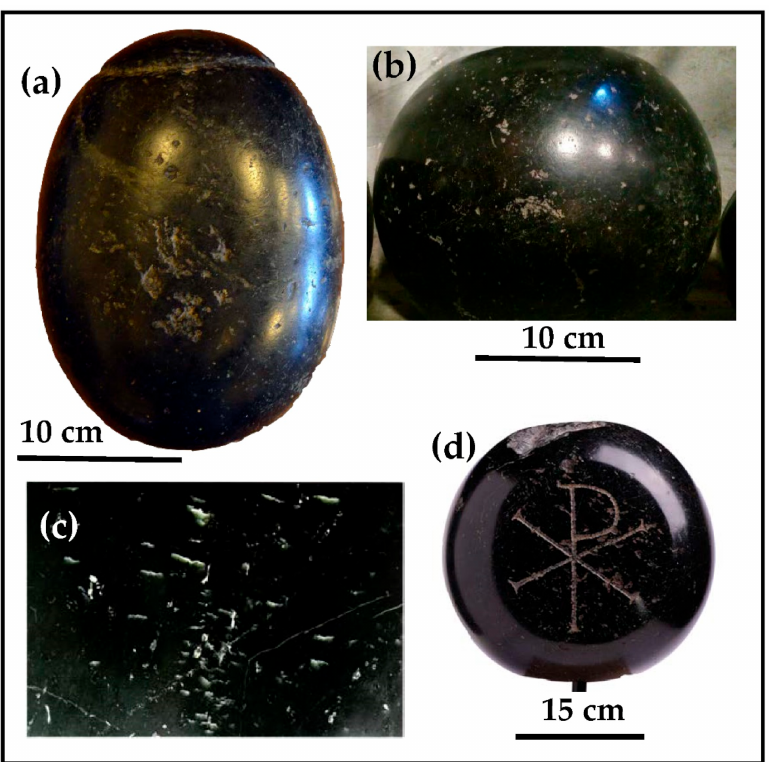
Figure 3. Macroscopic comparison among: ( a ) one of the black stones (1) from Leopardi’s child home; ( b ) Lapis Martyrum located at Santa Maria in Trastevere church (Rome); ( c ) particular of Lapis Aequipondus with permission of G. Giardini who took the photo [11] at the Lateran Museum (Rome); ( d ) Lapis Martyrum 4th century AD (private collection [12]).